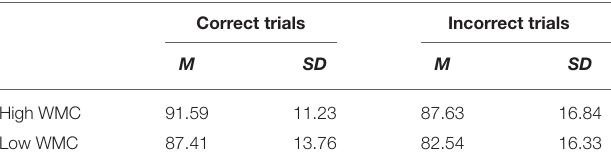
TABLE 7 | Mean confidence in correct word recall for correct and incorrect trials for high and low WMC